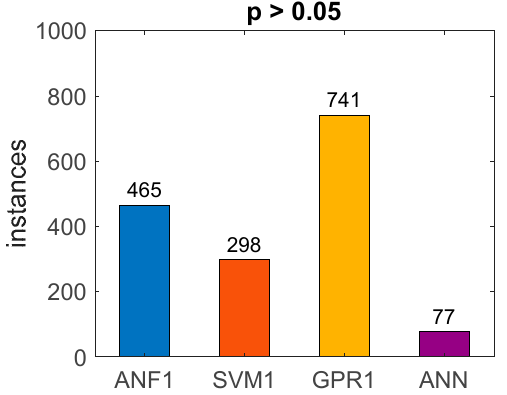
Figure 17. Results of t -test repeatability for chosen models.